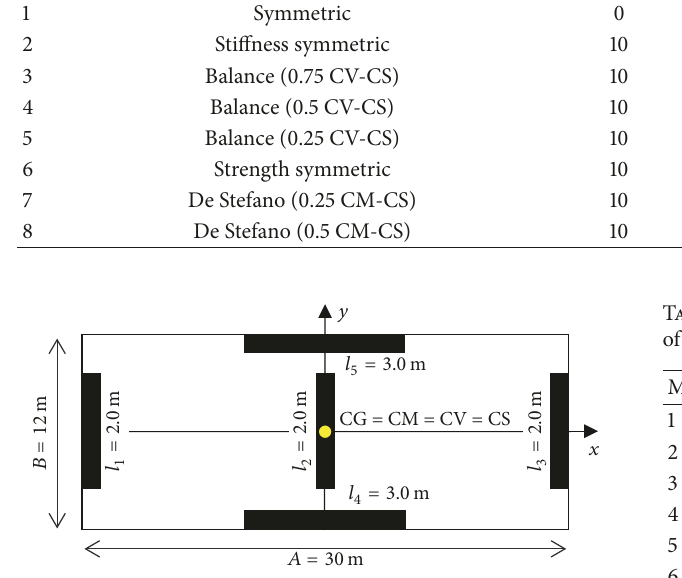
Figure 2: Plan view of the base symmetric model.